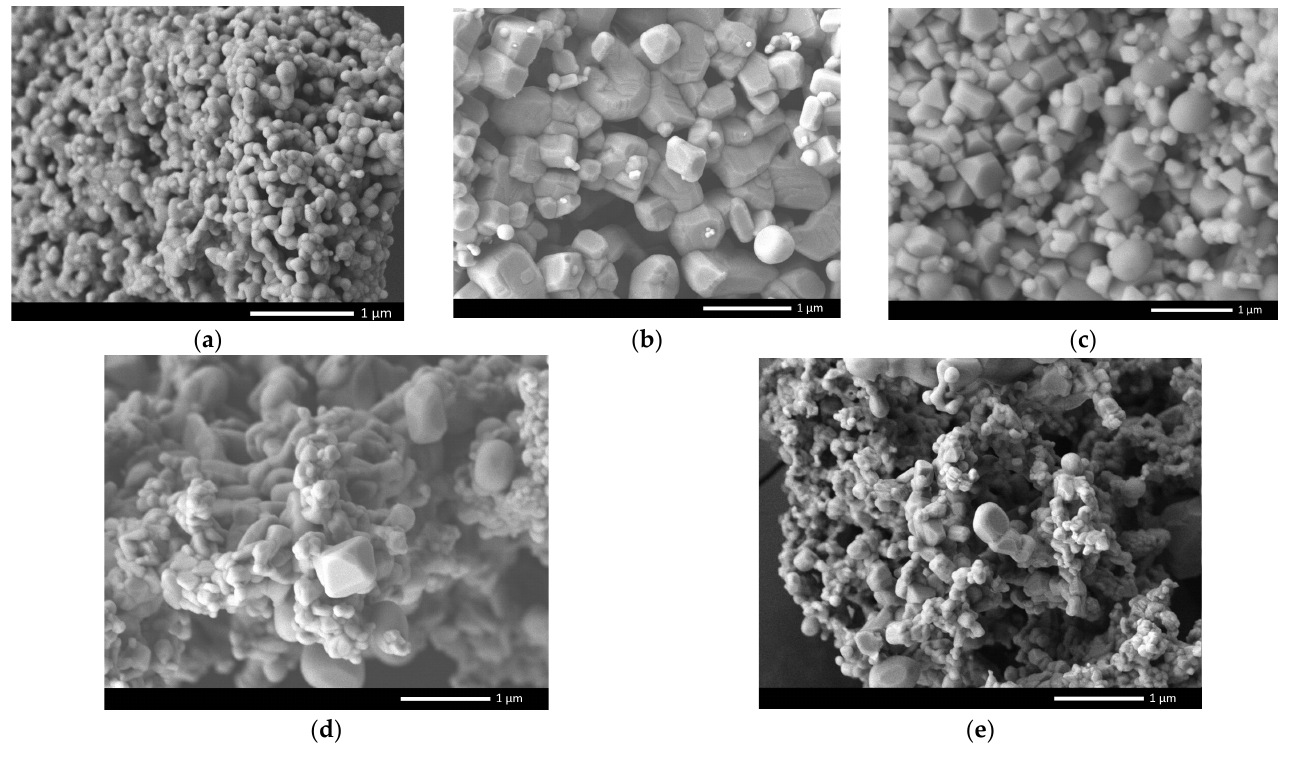
Figure 1. Data on the morphological features of the synthesized iron-containing nanocomposites: ( a ) Fe 2 O 3 nanoparticles; ( b ) Fe 2 O 3 @GdFeO 3 nanoparticles; ( c ) Fe 2 O 3 @NdFeO 3 nanoparticles; ( d ) CeFeO 3 nanoparticles; ( e ) YFeO 3 nanoparticles.